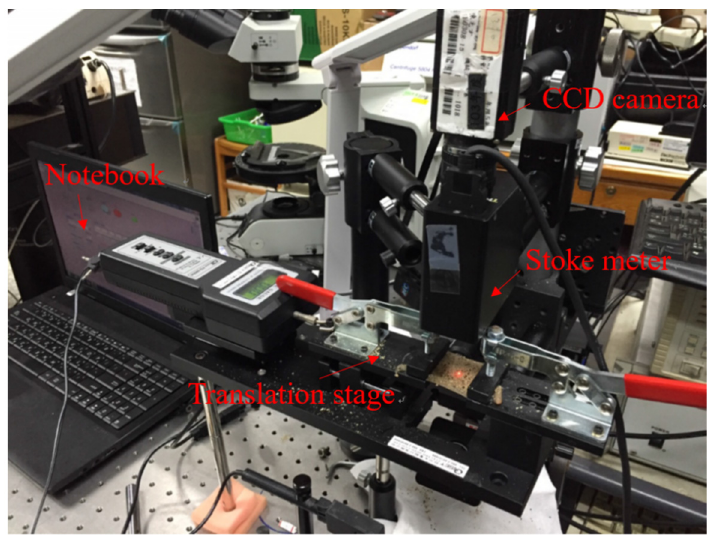
Figure 5. Experimental setup for biological tissue tensile testing.